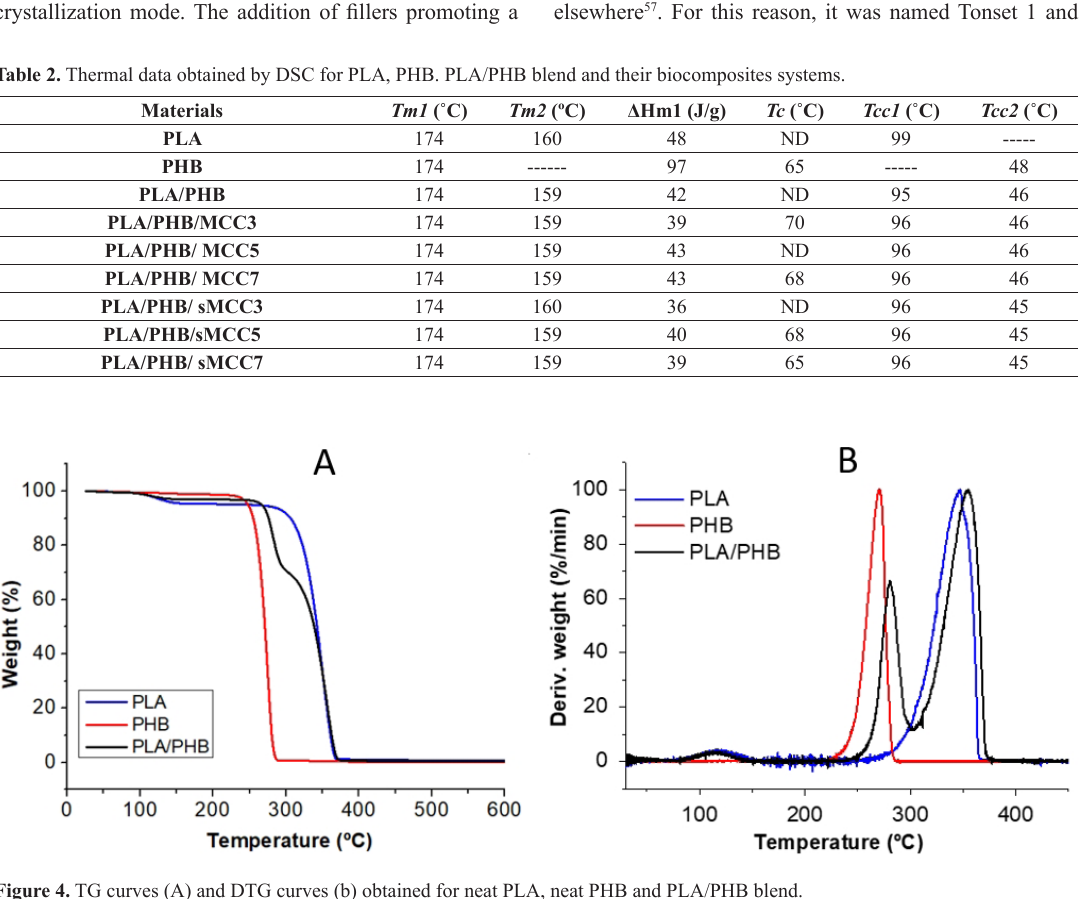
Figure 4. TG curves (A) and DTG curves (b) obtained for neat PLA, neat PHB and PLA/PHB